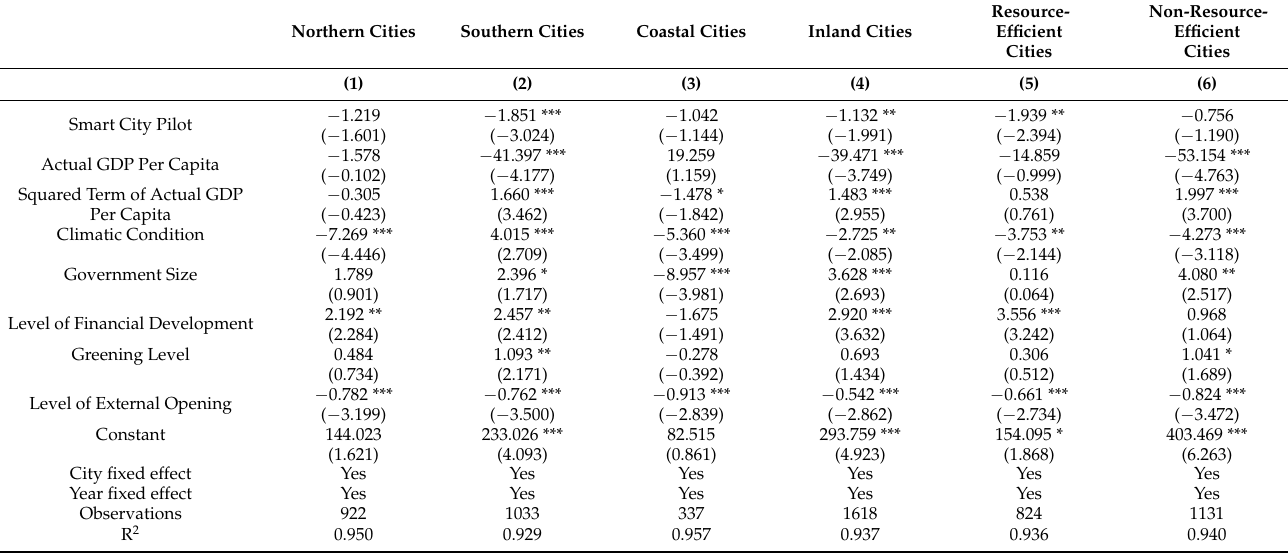
Table 6. Results of heterogeneity